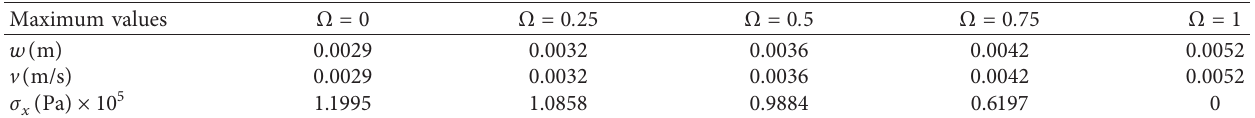
Table 10: Maximum deflections, velocities, and stresses at the central point of the FGP plate versus time ( k � 1). Maximum values Ω �